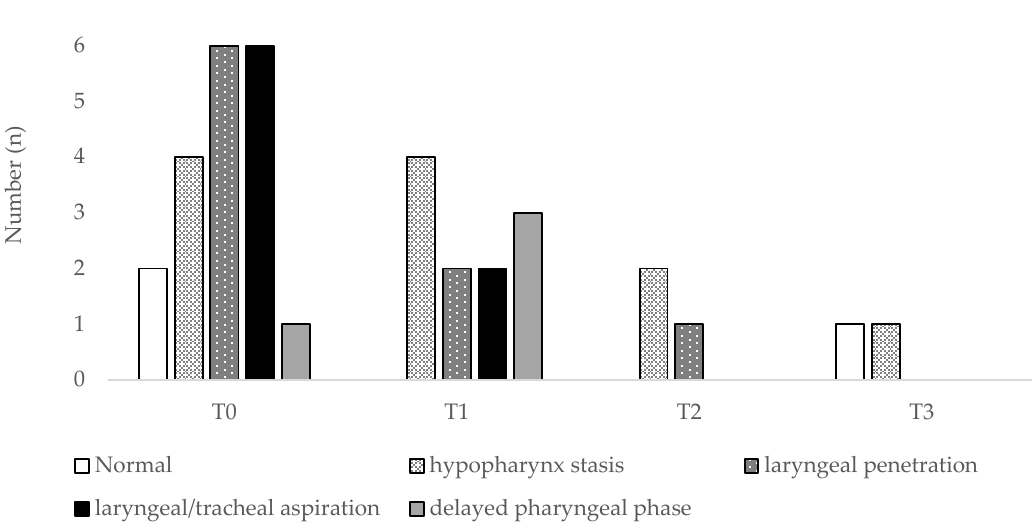
Figure 2. FEES findings in ALS bulbar-onset patients. T0 stands for the evaluation at the time of diagnosis, T1, T2 and T3 stand for follow-up trimesters.